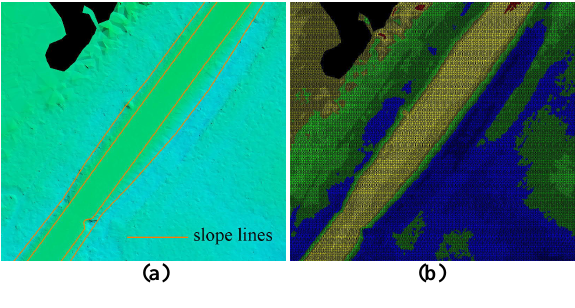
Figure 11 . Digital elevation model: (a) DEM based on ground laser points; (b) ground points interpolated by 20 cm grid.